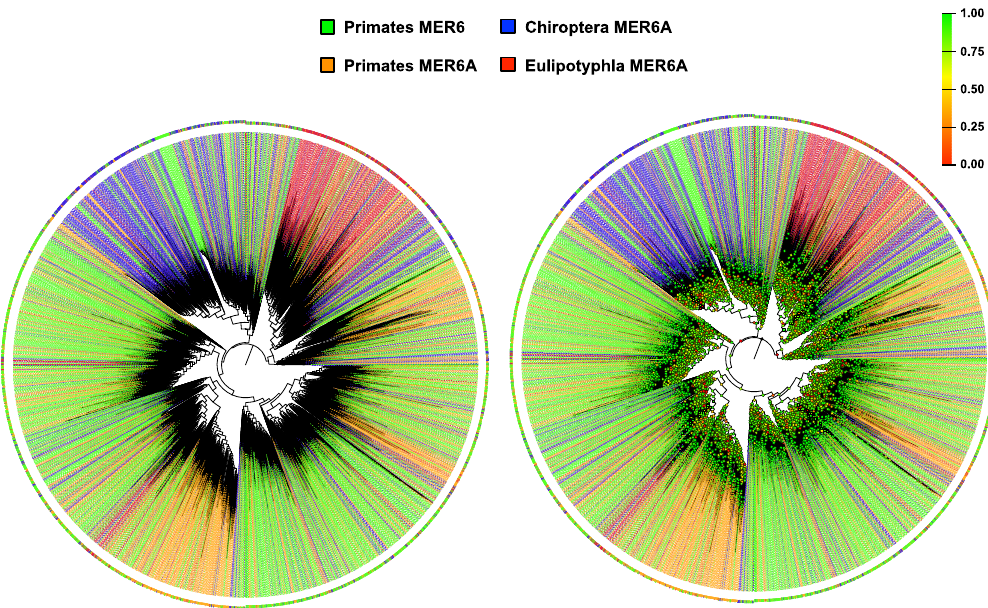
Figure 2. Maximum likelihood phylogenetic analysis on 2438 MER6 and the 6150 MER6A copies isolated from primates, chiropterans and eulipotyphlans. In the left panel, the maximum likelihood tree calculated using the Jukes–Cantor + CAT model without node supports for improving the graphical clarity. In the right panel, the same phylogenetic tree with node support represented by coloured dots as per the upper-right legend.